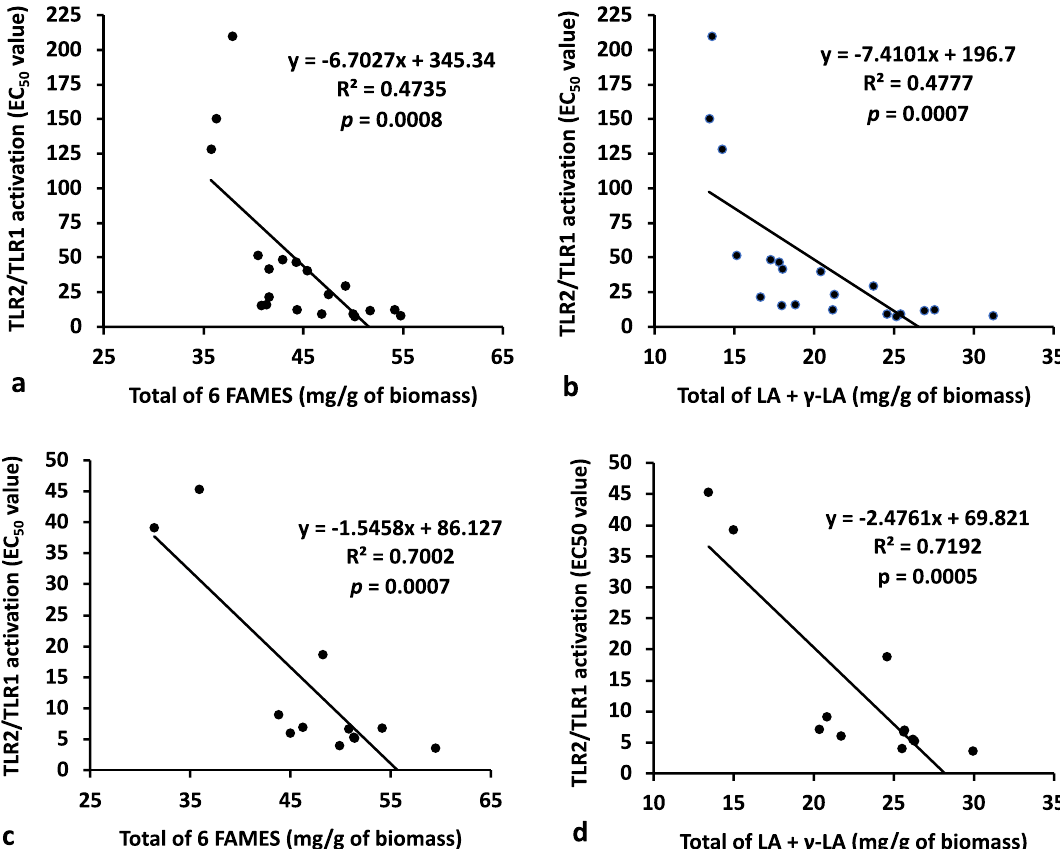
Figure 4. Correlations between TLR2/TLR1 extract activity and content of fatty acids in biomass material obtained from Dongtai Cibainian Biological Engineering (20 batches, a and b ) and commercial growers in 10 different countries (12 batches, c and d ). The total content of 6 fatty acids represents the combined total of palmitate, palmitoleate, stearate, oleate, linoleate, and γ-linolenate in each sample ( a , c ). “LA” and “γ-LA” represent linoleate and gamma linolenate, respectively. EC 50 values represent the concentration (µg/mL) of biomass material required to induce activation for the TLR2/TLR1 signaling pathway to levels 50% of those achieved by Pam 3 CSK 4 (100 ng/mL).